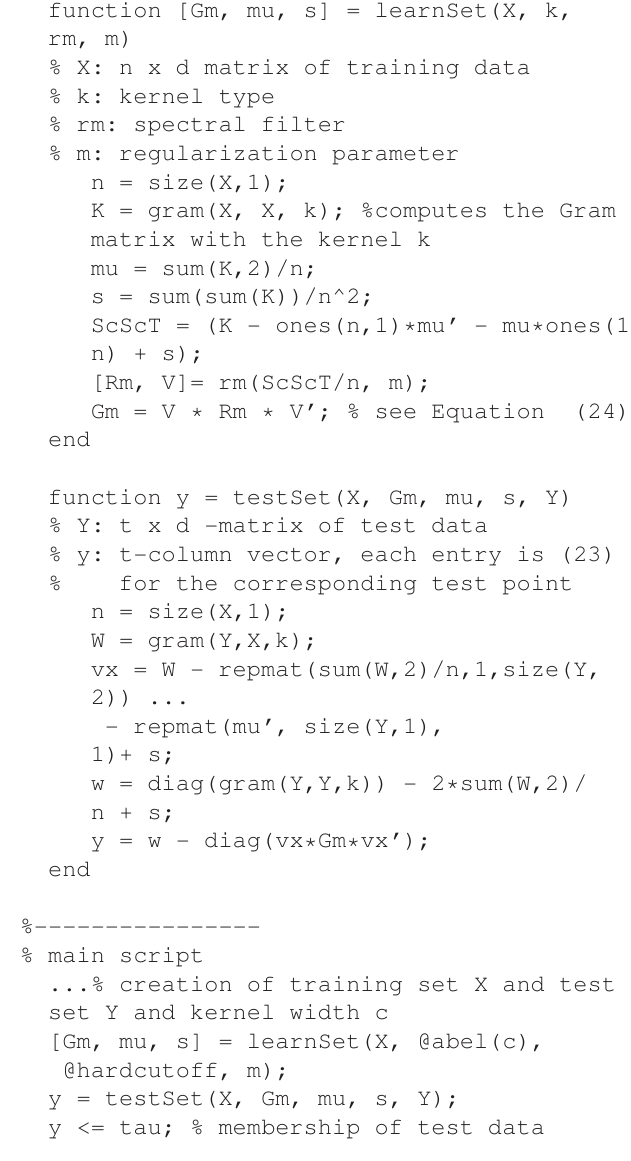
Algorithm 1 Matlab code for Set